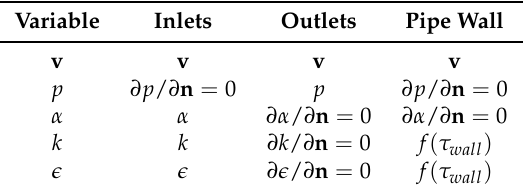
Table 3. Boundary conditions summary for the multiphase